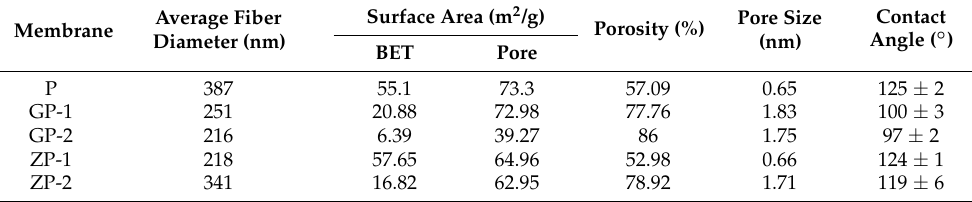
Figure 8. Nitrogen adsorption – desorption isotherms of fabricated membranes. Table 5. Surface properties of fabricated membranes.